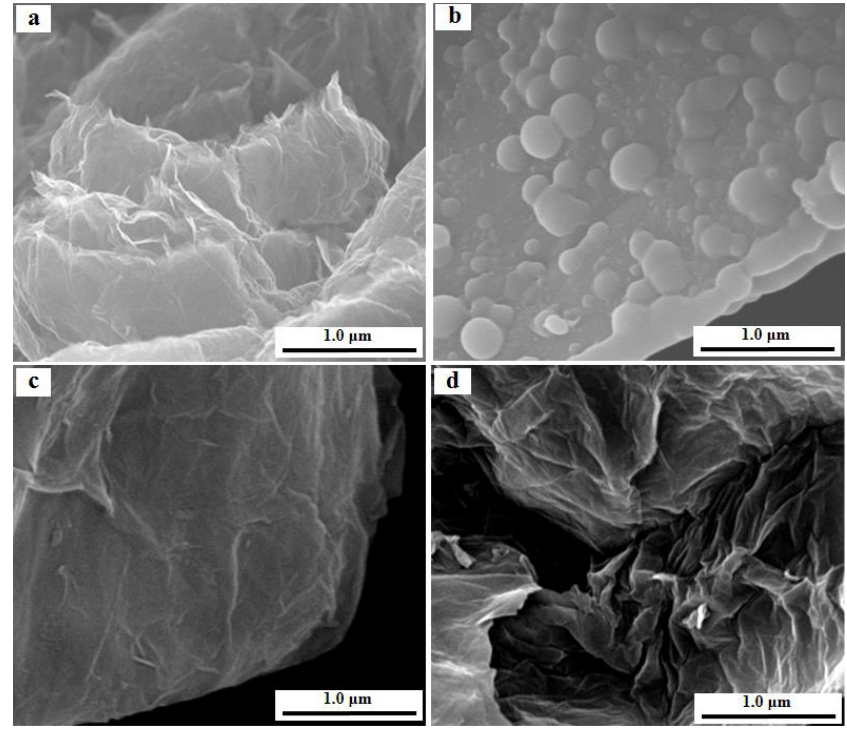
Figure 3. SEM images of ( a ) rGO, ( b ) PZS@rGO4%, ( c ) PZS@rGO8% and ( d ) PZS@rGO12%.